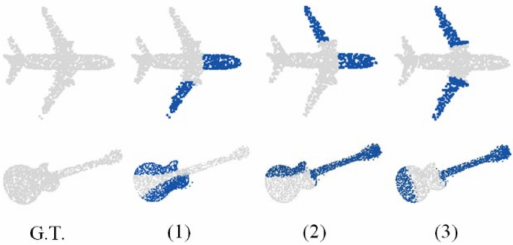
Figure 8. Examples of repairing results with missing point clouds at multiple locations. (1–3) Blue represents the prediction. Gray denotes the undamaged point